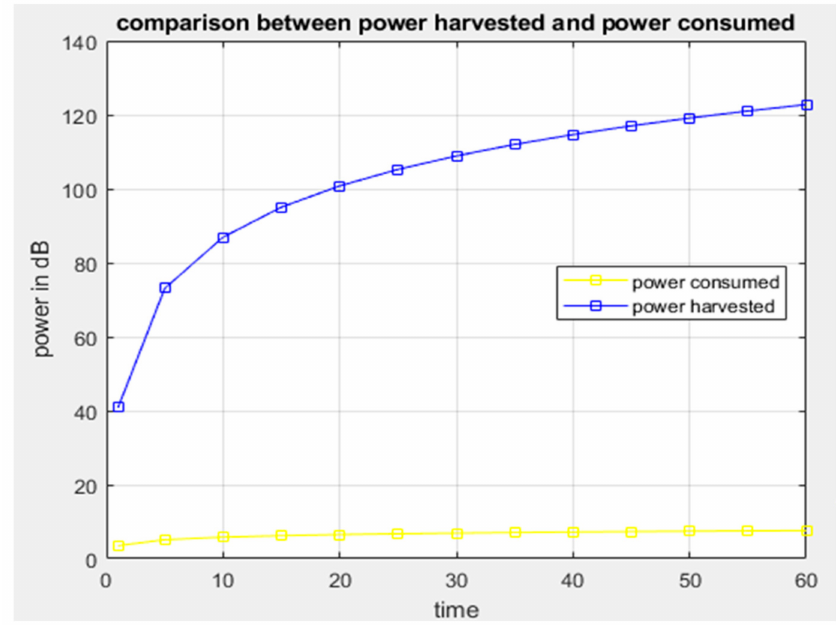
Figure 10. Graph of power harvested vs. power